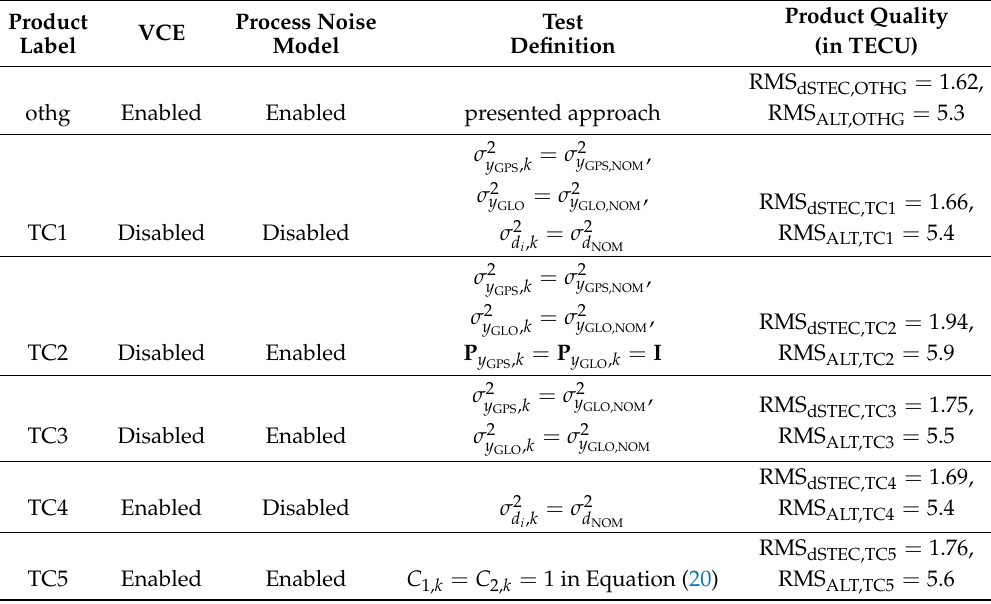
Table 1. Test cases with different KF settings used in the model